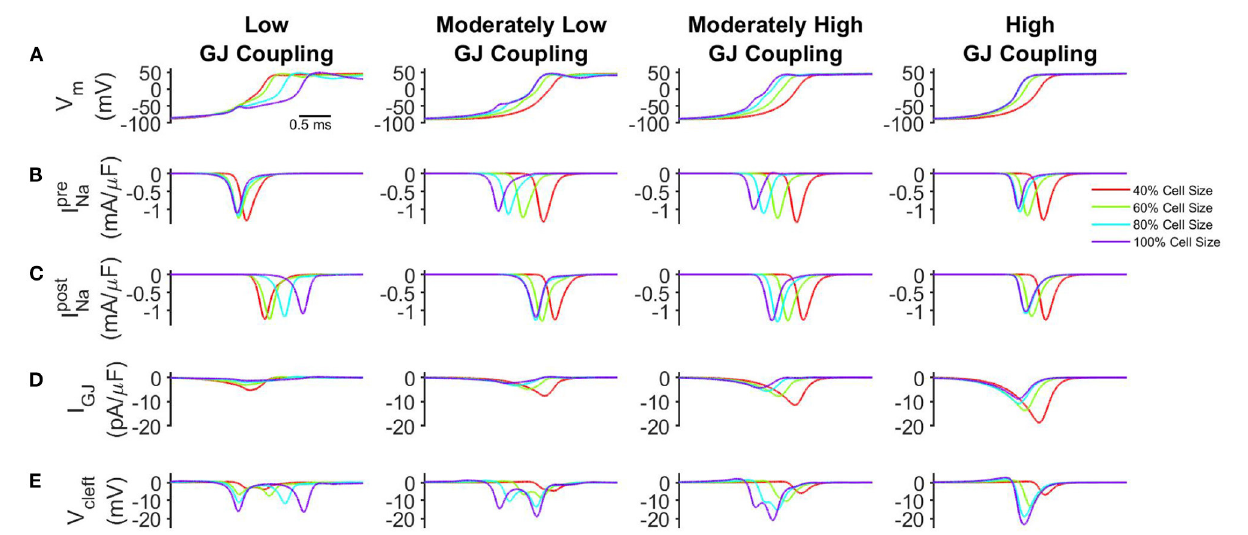
FIGURE 2 | Conduction velocity (CV) depends on cell size and GJ coupling. (A) Transmembrane voltage of the post-junctional node of the ID ( V m ), (B) Na + current at the pre-junctional node of the ID ( I pre Na ), (C) Na + current at the post-junctional node of the ID ( I post Na ), (D) GJ current at the ID ( I GJ ), and (E) cleft voltage ( V cleft ) are shown in tissue for low (50.6 nS), moderately low (101 nS), moderately high (253 nS), and high (1,266 nS) GJ coupling. For clarity, traces are shown for the same spatial point of 1.2 mm from the pacing site. Parameters: ID Na = 50%, ρ Na = 100%, w = 20 nm